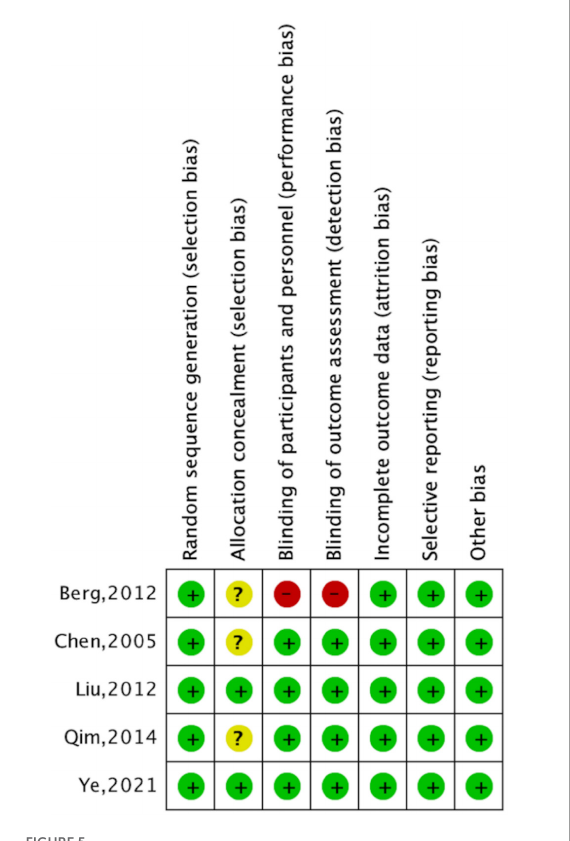
FIGURE5 Risk of bias summary, with risk of each type of bias in included studies presented separately. Note: +, ?, – indicate high, uncertain, and low bias,